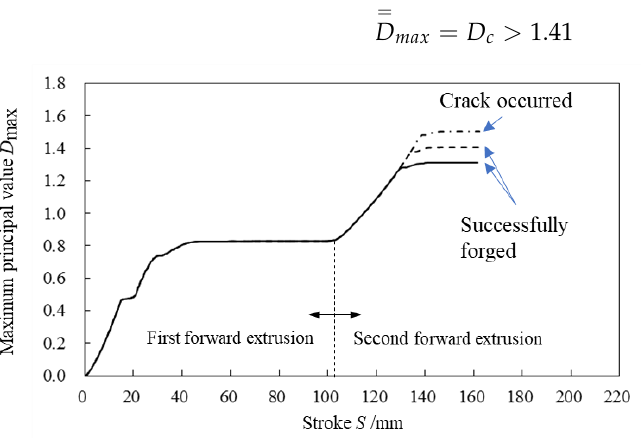
Figure 25. Change in ductile fracture value during multiple forward extrusion processes .